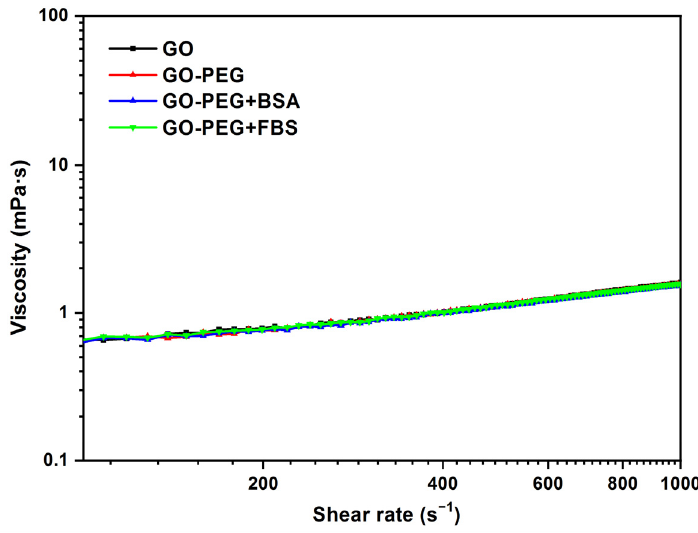
Figure 8. Viscosity ( η ) vs. shear rate ( γ(cid:4662) ) for 0.125 mg/mL dispersions of GO, GO-PEG, GO-PEG + BSA, and GO-PEG + FBS. Temperature: 37 °C.